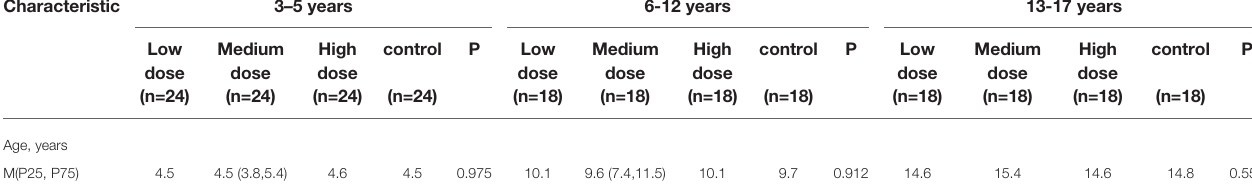
TABLE 1 | Baseline characteristics of the study participants. Table 1.1 Baseline Characteristics of the Study Participants in the Phase 1 Clinical Trial a Characteristic